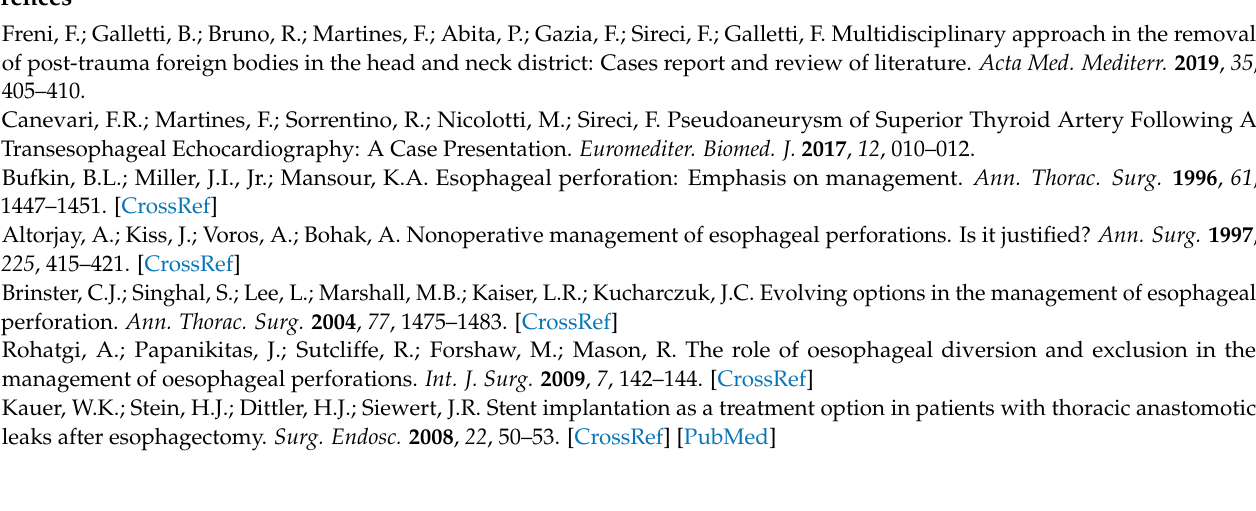
Table S3, detailed information of the 4 studies included patients with fistula; Table S4, patients’ characteristics of studies comparing endoscopic vacuum therapy and self-expanding metal stent, and Table S5, methodological